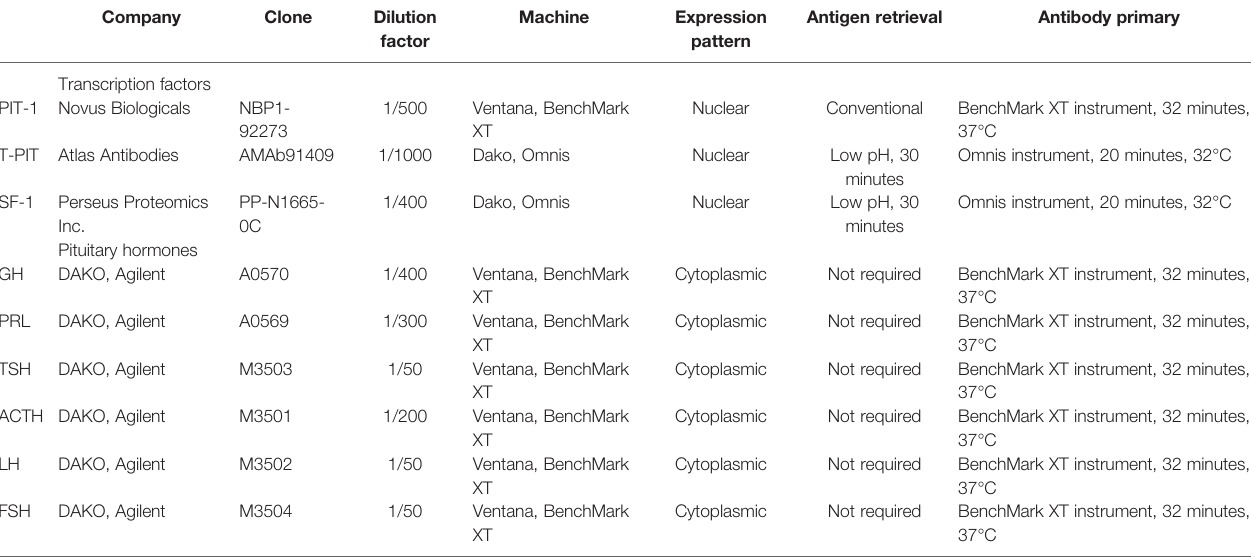
TABLE 1 | Antibodies used for immunohistochemistry for transcription factors and pituitary hormones.